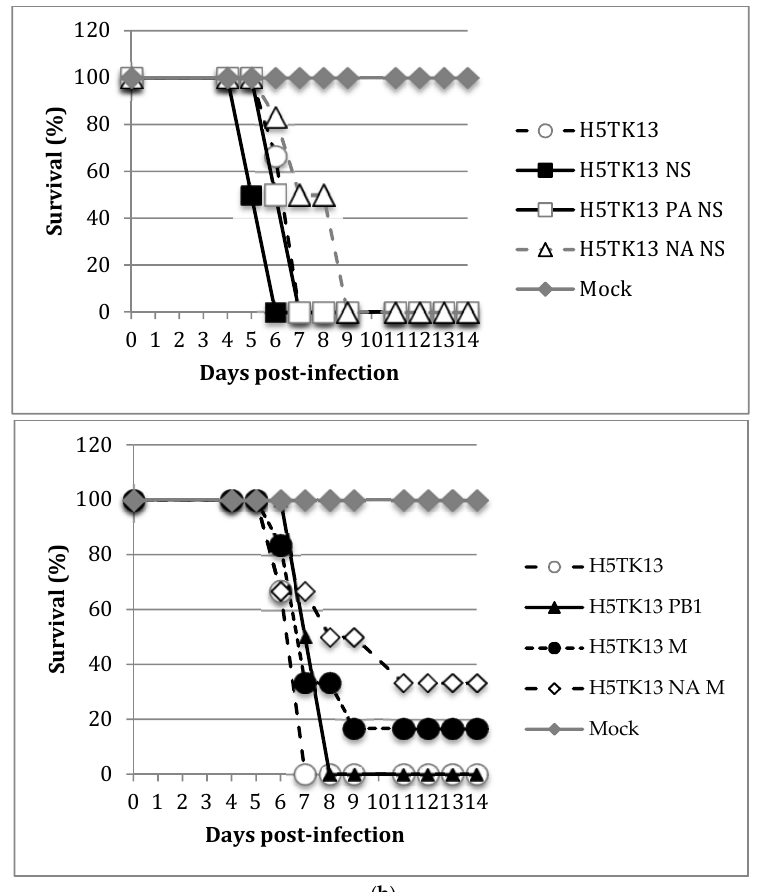
Figure 2. Pathogenicity of reassortant viruses in mice. Morbidity (weight loss) ( a ) and mortality ( b ) of mice inoculated with 10 5 TCID 50 reassortant viruses. The data for the mock and H5TK13-infected mice are reported in each graph.